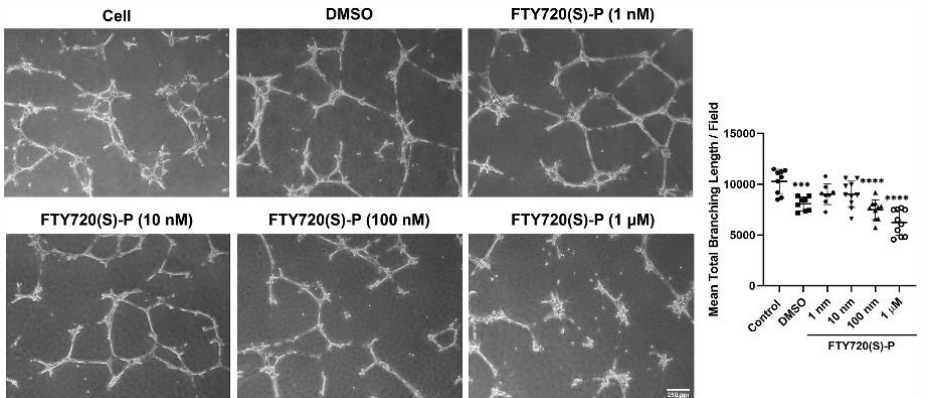
Figure 6. An enantiomer of the phosphorylated S1PR agonist FTY720 inhibits ChEC capillary morphogenesis. Detached ChECs were incubated with varying concentrations of phosphorylated S1PR agonist (in DMSO) or DMSO on ice for 20 min. Incubated cells were then applied to Matrigel-coated plates, incubated, and photographed after 14 h as described in Methods. The mean number of branch points was determined. *** p < 0.001, **** p < 0.0001. ( n = 3).